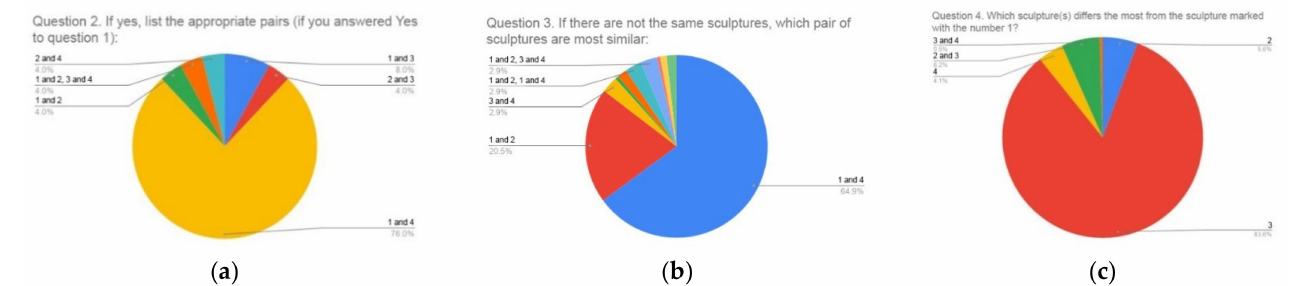
Figure 17. Graph of the answers to: ( a ) question number 2; ( b ) question number 3; ( c ) question number